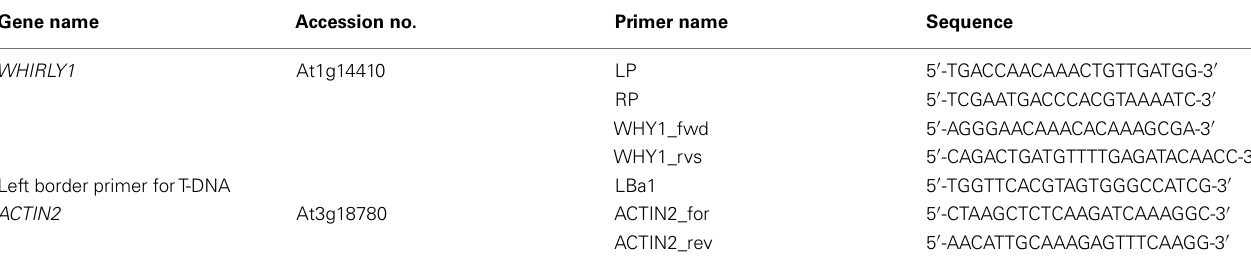
TableA1 | Gene specific primers that were used in this